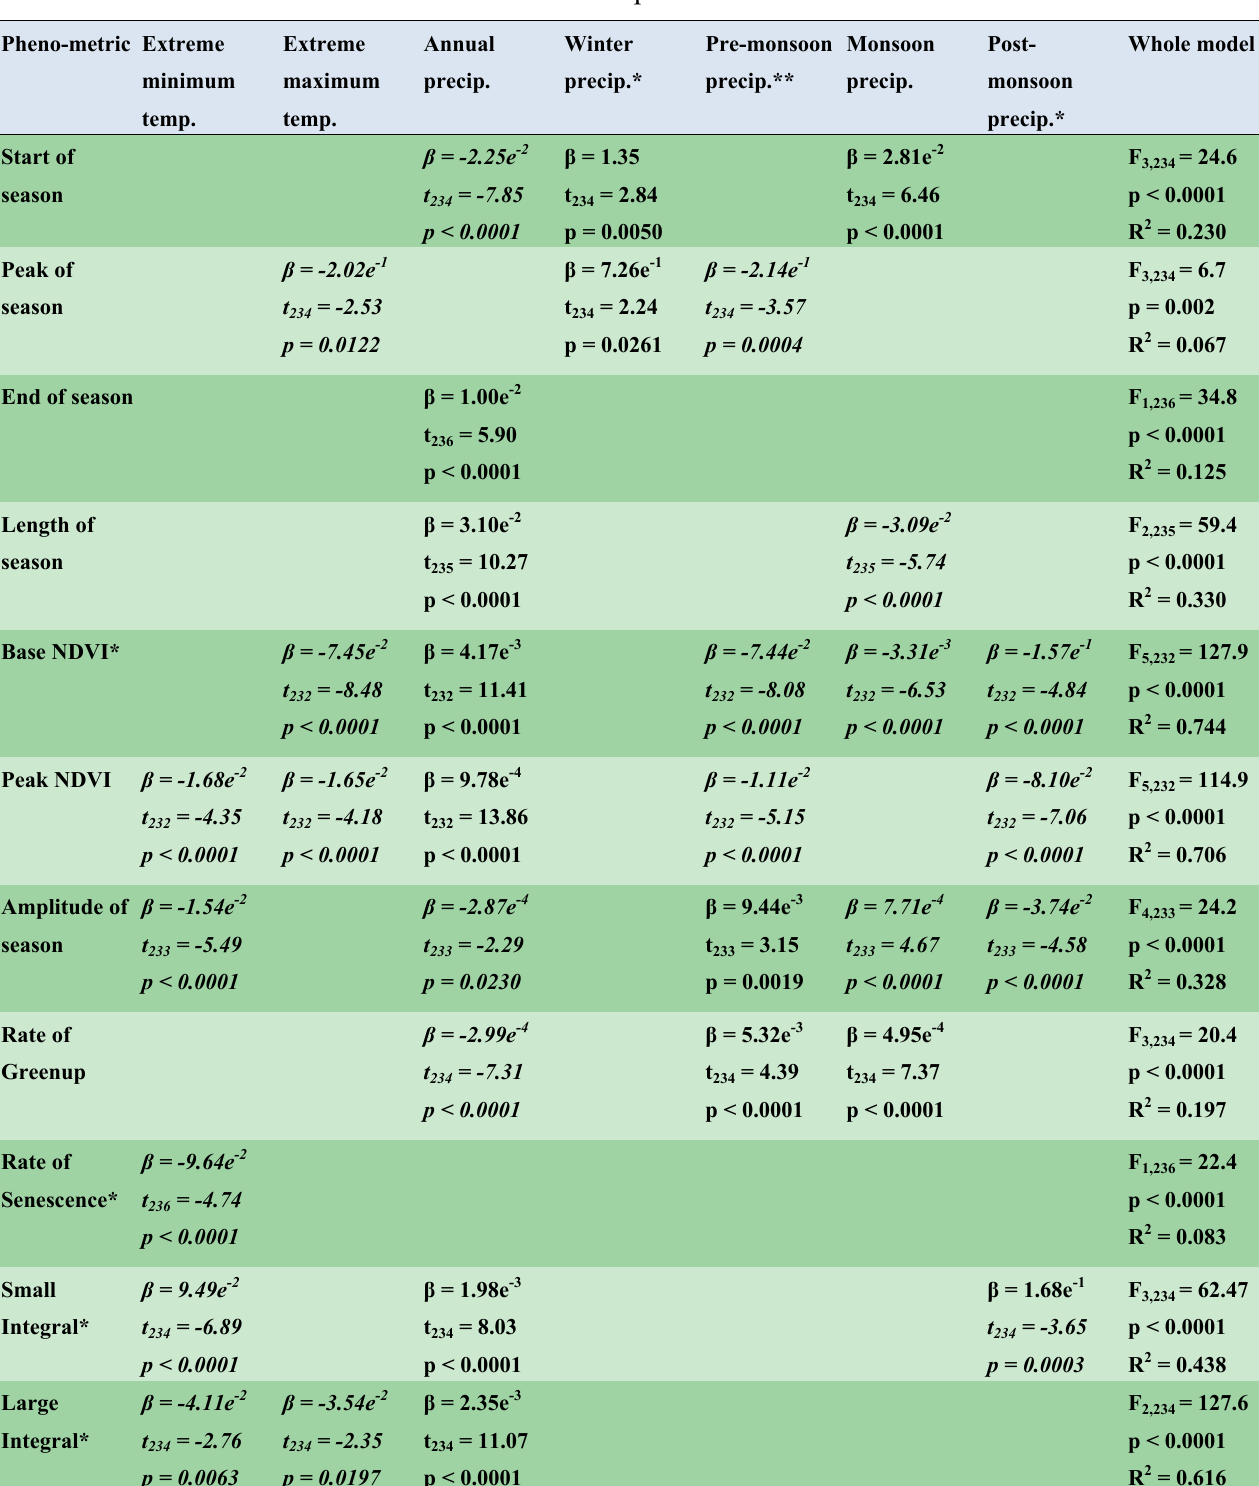
Table 2. Results of stepwise regression of climate variables for each phenometric, for sites across the Santa Rita Mountains, AZ (n = 238; degrees of freedom listed with test statistics; R 2 values are adjusted to account for multiple variables). Negative associations are indicated by italics. * = data were log transformed; ** = data were square-root transformed. Both transforms were made to improve the normal distribution of the